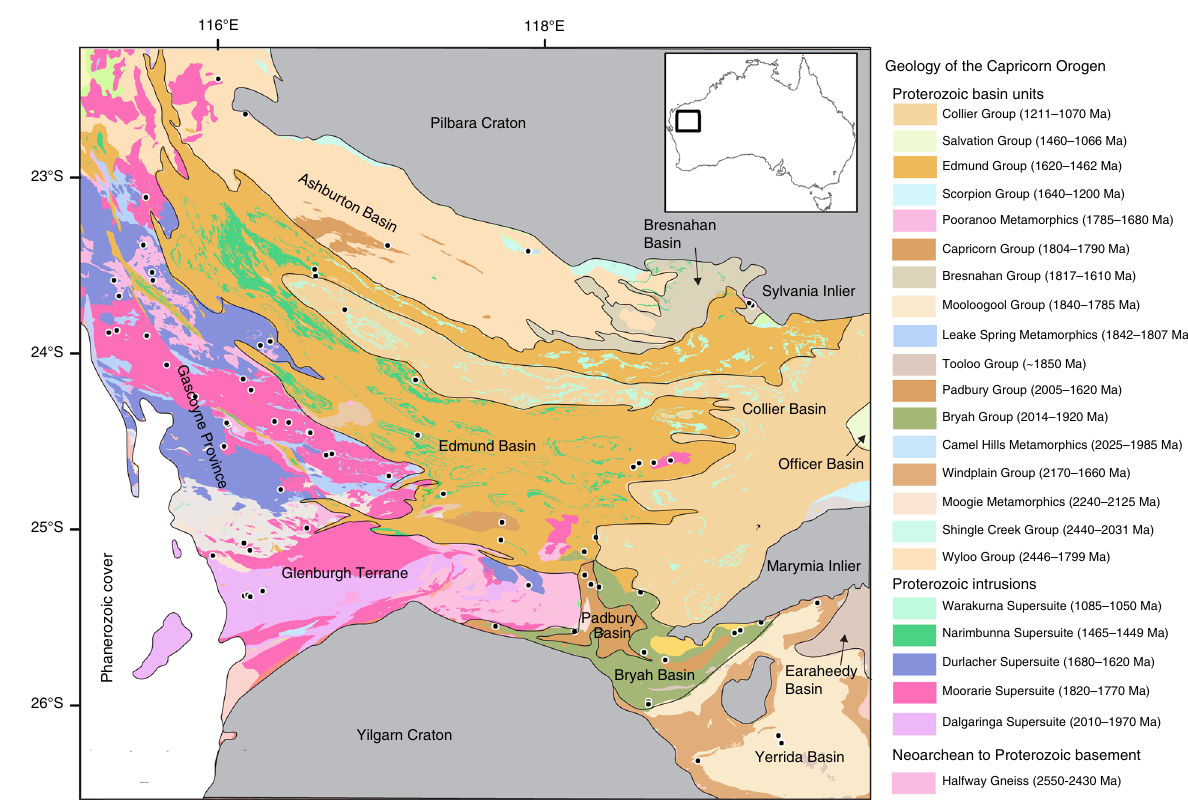
Fig. 1 Geological map of the Capricorn Orogen with sample locations. Black dots are locations of samples analyzed for multiple sulfur isotopes to form the interpolated Δ 33 S isotope model. Ages of formal groups from the Geoscience Australia ’ s Australian Stratigraphic Units